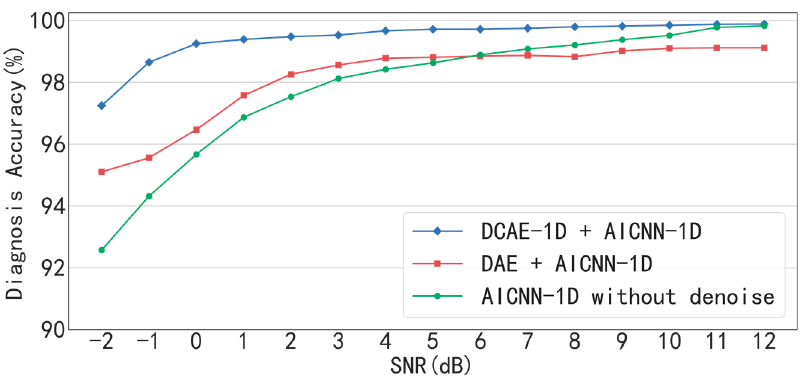
Figure 15. Diagnosis accuracy of AICNN-1D with different denoising process (delete something).